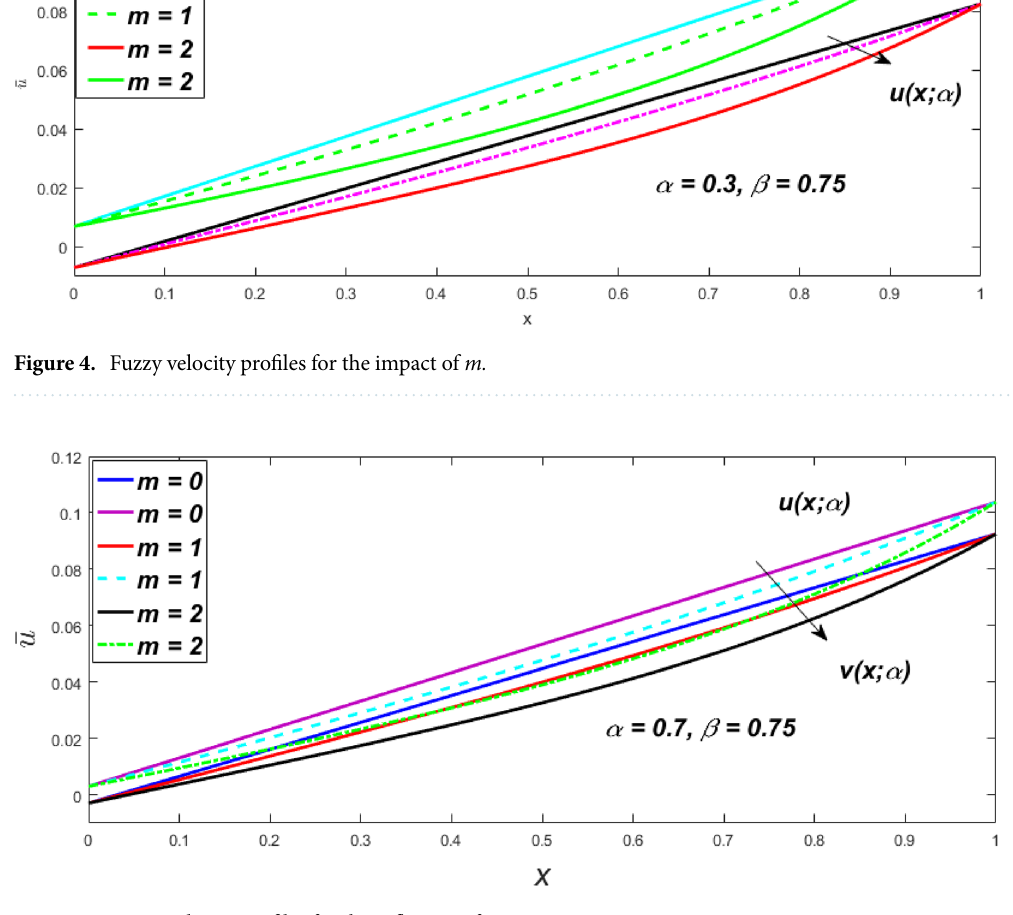
Figure 5. Fuzzy velocity profiles for the influence of m.